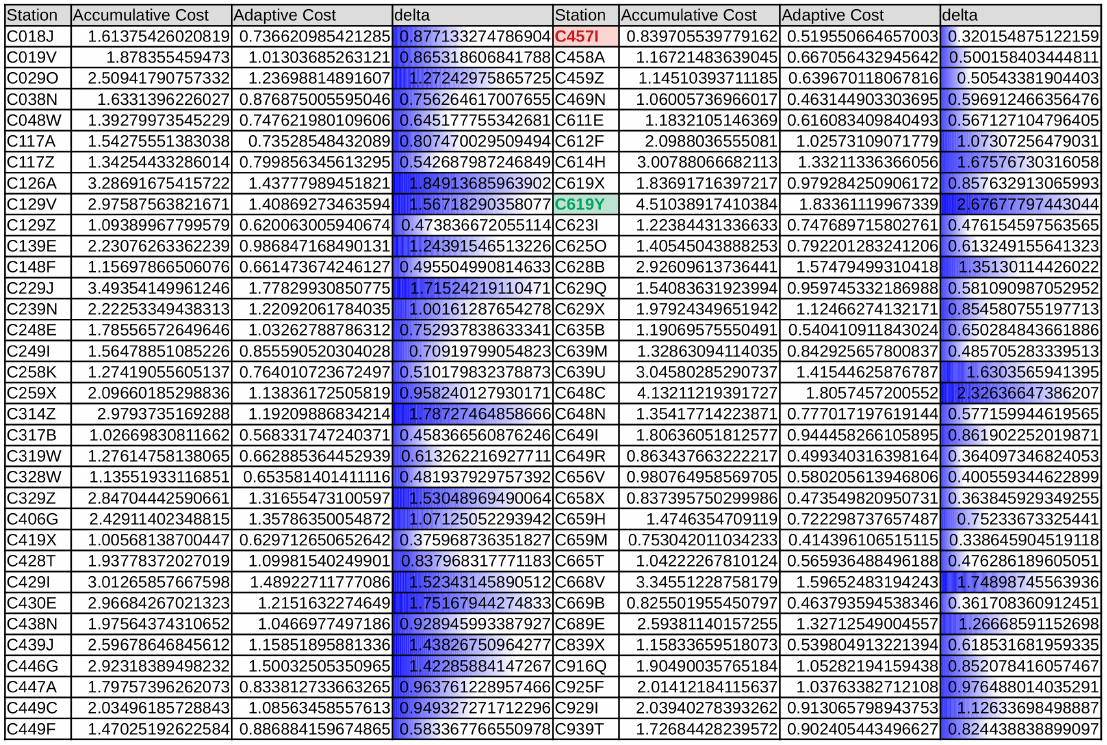
Figure 5. Mean accumulative and adaptive cost ((m/s) 2 ) for weather stations (estimated values vs. observed values for the two strategies) and difference between the